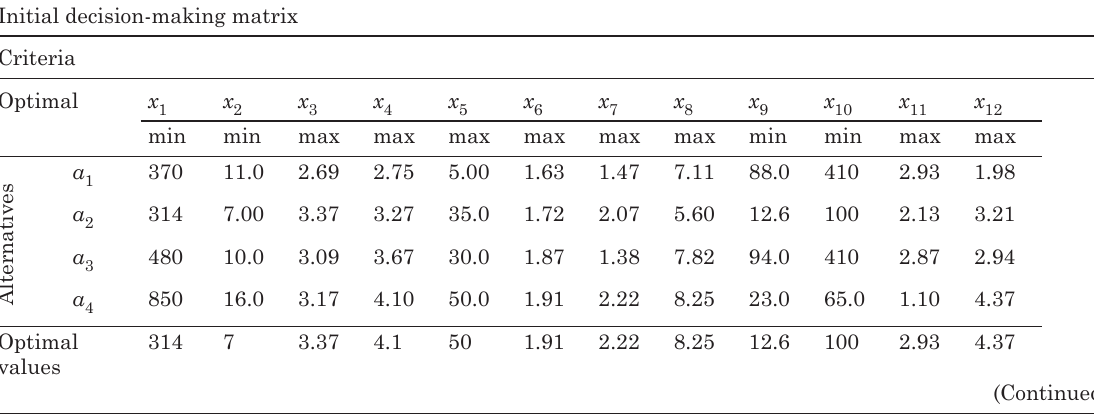
Variability level Criteria weights